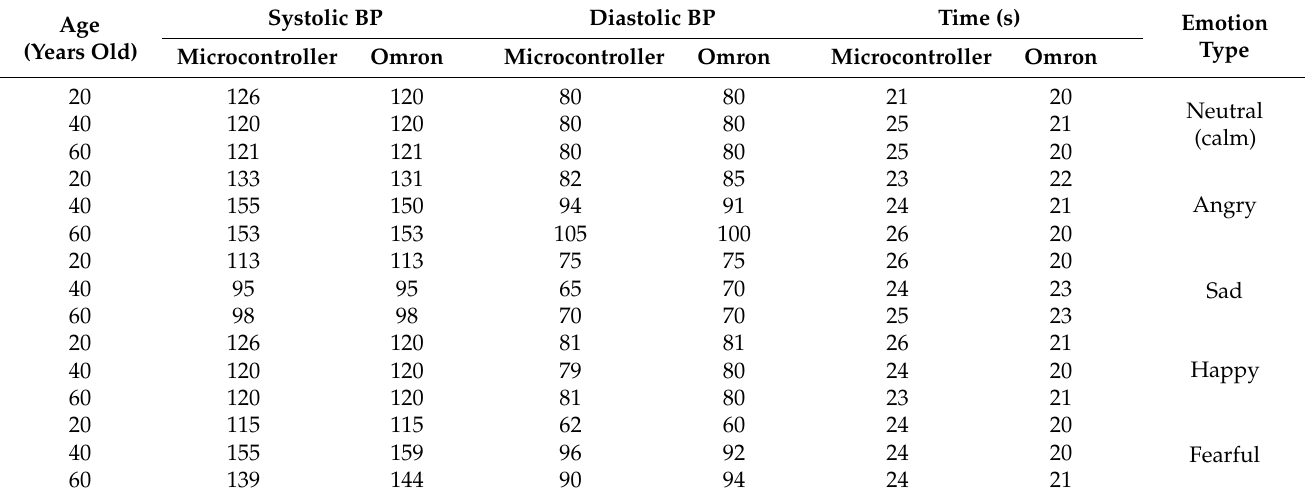
Table 1. Average Blood Pressure